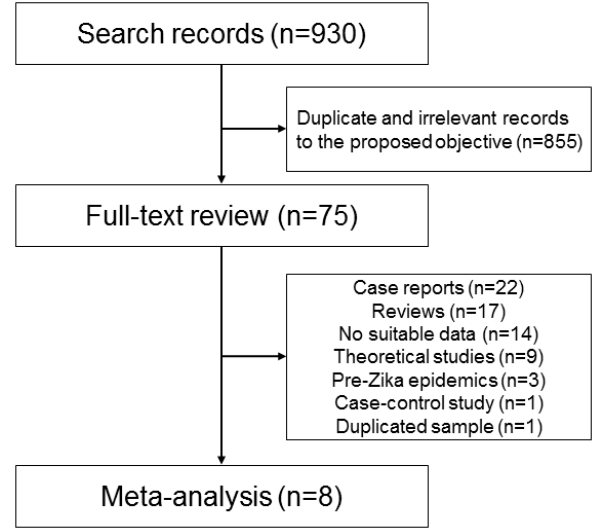
Figure 1. Flowchart of studies selected for review and inclusion on meta-analysis modeling.